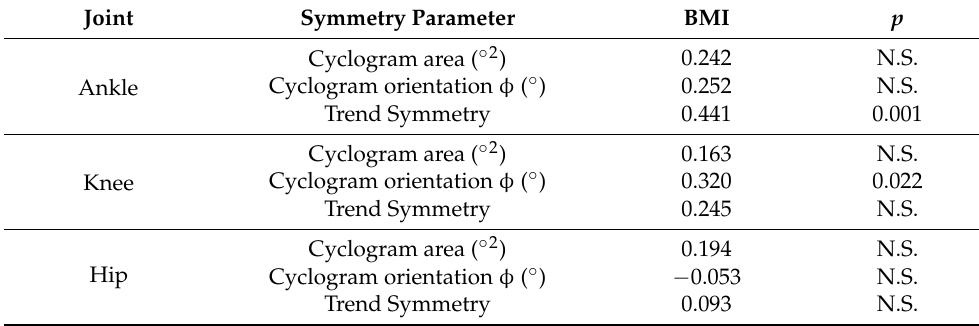
Table 5. Partial correlation coefficients between BMI and interlimb symmetry